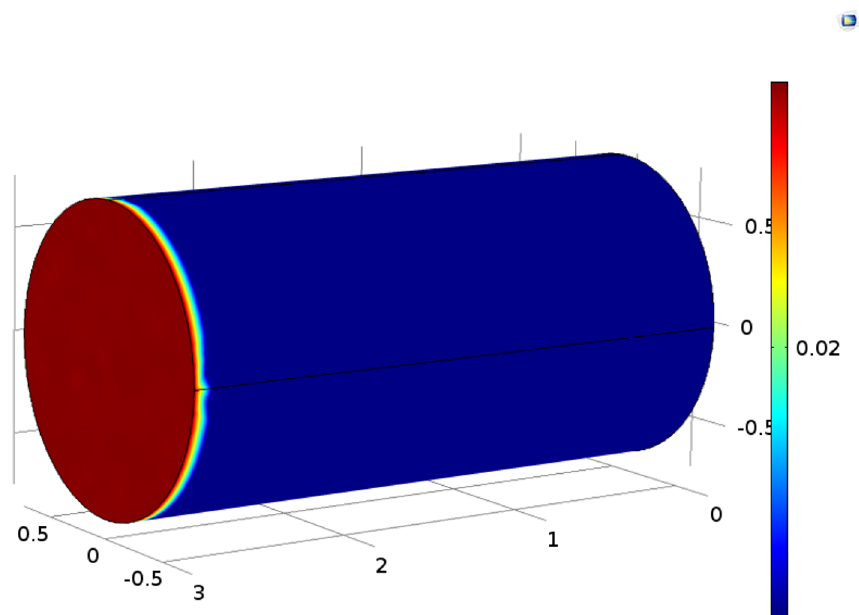
Fig. 17 Initial silica gel precipi- tate distribution at the beginning of acid